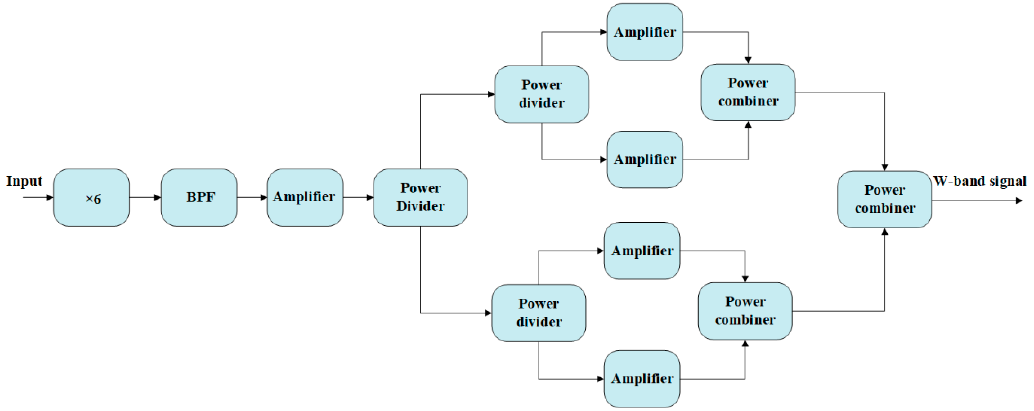
Figure 4. The block diagram of the W-band source.